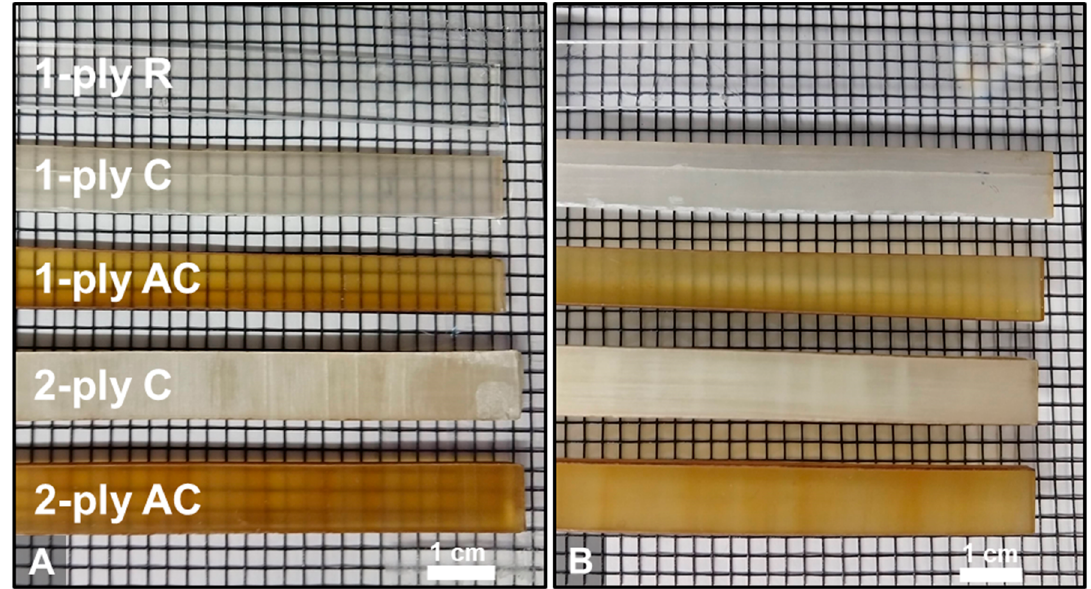
Figure 1. Images of selected TWC specimens demonstrating optical transparency. ( a ) The TWCs are flat on the grid and ( b ) the TWCs are raised 1 cm above the grid. (R—PMMA-based resin, C—delignified wood template, AC—acetylated delignified wood template).